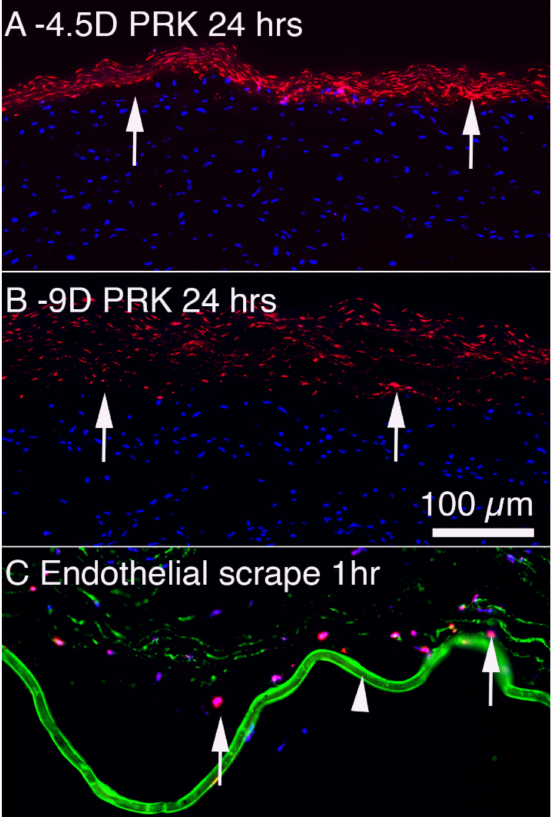
Figure 4. Keratocyte apoptosis in response to injury in rabbit corneas. ( A ) TUNEL assay at 24 h after − 4.5D PRK that entails epithelial debridement and then anterior stromal ablation with the excimer laser. Arrows indicate anterior stromal keratocytes undergoing apoptosis. The apoptotic cells can be detected with TEM within moments of epithelial scrape but become strongly TUNEL+ from 4 to more than 24 h. Many bone marrow-derived cells such as monocytes and fibrocytes detected with markers such as CD34, CD45, and CD11b infiltrate the stroma from the limbus and many also undergo apoptosis in the first 24 to 72 h. ( B ) At 24 h after − 9D PRK, with twice the number of excimer laser pulses, many more anterior stromal keratocytes (arrows) undergo apoptosis. Thus, there is a correlation between the magnitude of the anterior corneal injury and the number of keratocytes that undergo early apoptosis [19]. ( C ) At 1 h following an 8 mm corneal endothelial scrape injury, many posterior stromal keratocytes (arrows) undergo apoptosis detected with the TUNEL assay. Note the edema of the stroma that also occurs immediately after endothelial injury. The arrowhead indicates DBM stained (green) for BM component nidogen-1. Figures ( A , B ) were previously unpublished but from the study of Mohan et al., 2003 [19]. Figure ( C ) reprinted with permission from Medeiros et al. Exp. Eye Res. 2018;